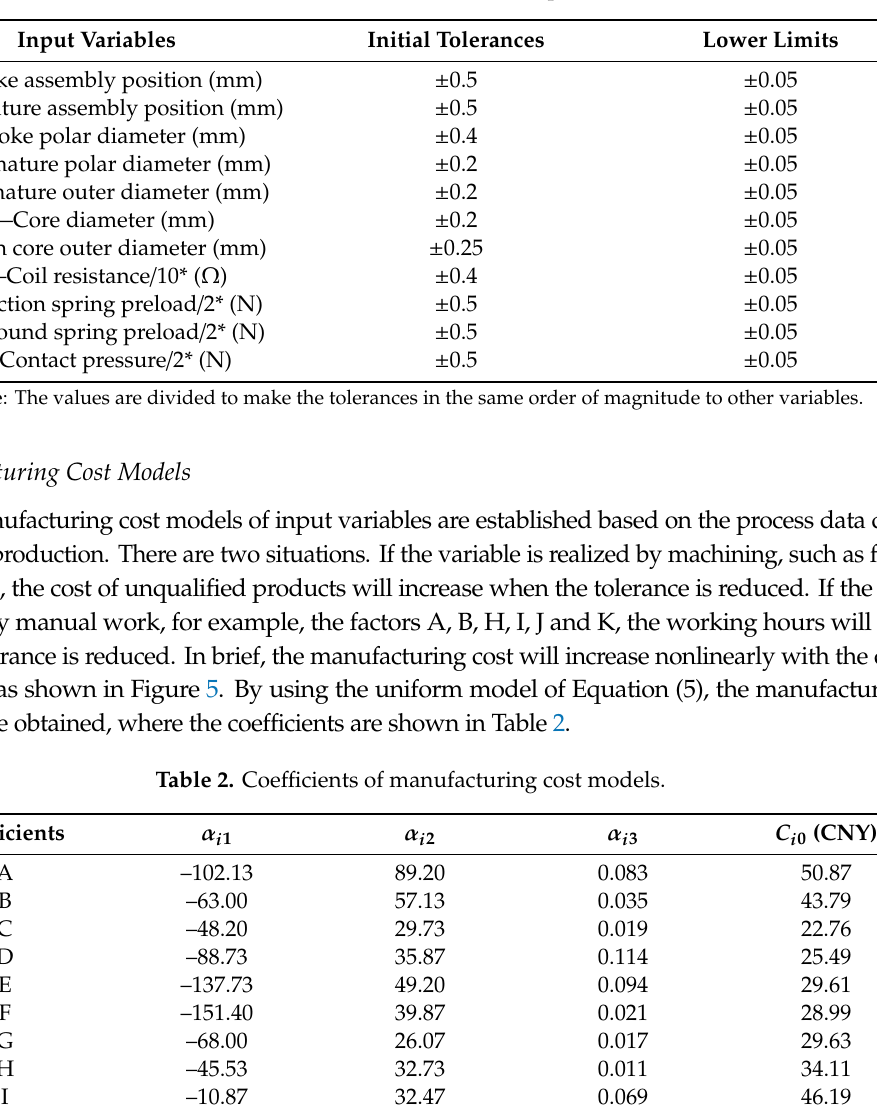
Table 1. Tolerances and lower limits of input variables.